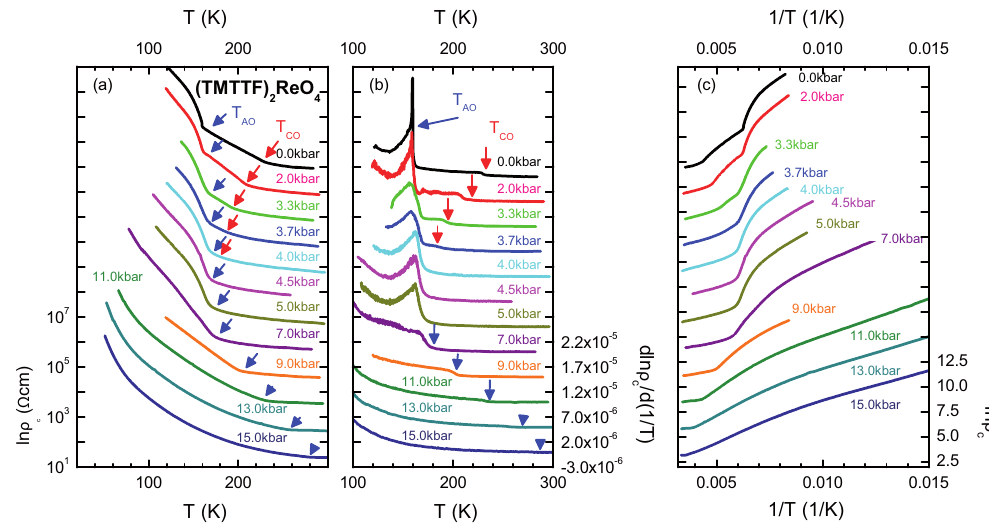
Figure 14. ( a ) Temperature-dependent resistivity of (TMTTF) 2 ReO 4 measured along the c ∗ -direction for different values of external pressure. The red and black arrows indicate the charge order and anion order transition temperatures. ( b ) The temperature derivative dln ( ρ ) /d ( 1/ T ) shows the charge-order transition as a step in the temperature dependence; the anion ordering T AO is seen as a pronounced peak. Both exhibit a distinct pressure dependence. ( c ) Arrhenius plot of the resistivity ρ c ( T ) as the pressure increases. All curves are shifted with respect to each other for clarity